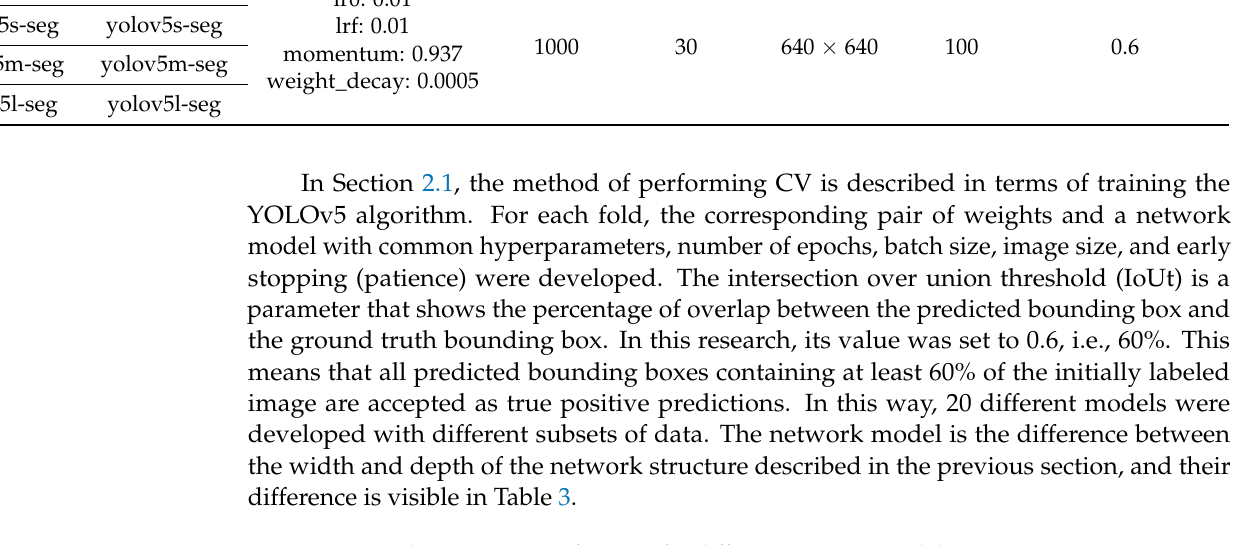
Table 3. Network structure specifications for different YOLOv5